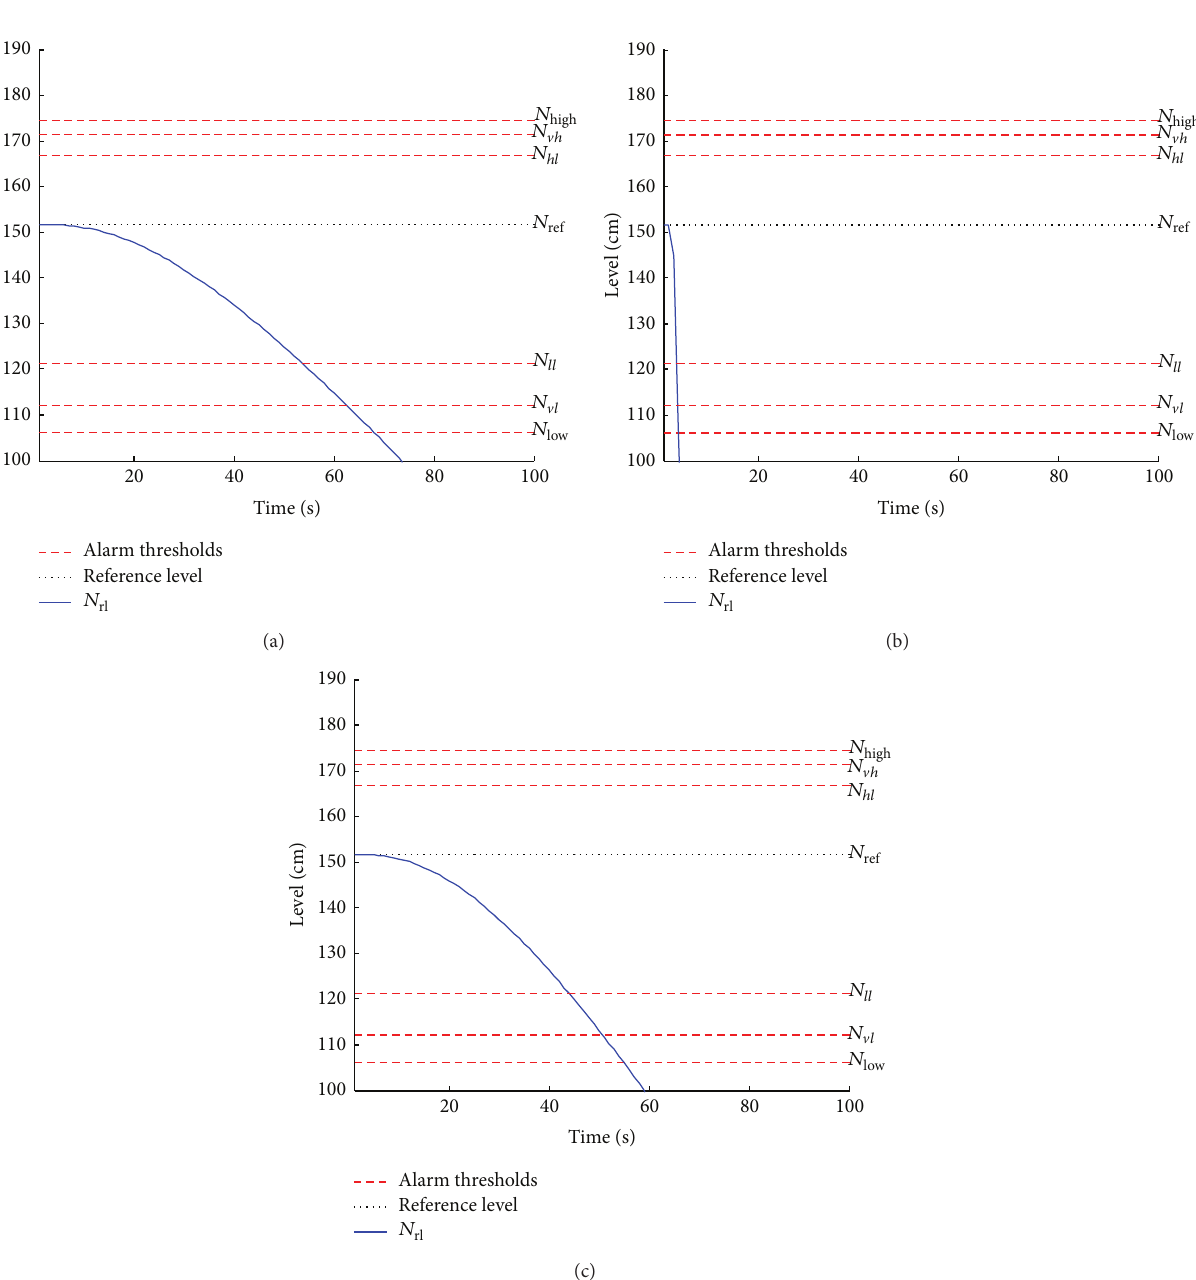
Figure 21: (a) 𝑁 evolution when simultaneously the safety relief valve fails stuck with 𝑄 rl steam valve fails stuck closed; (c) the PID controller fails stuck at 18% of the nominal 𝑄 𝑒 that should be provided at 80% 𝑃 𝑛